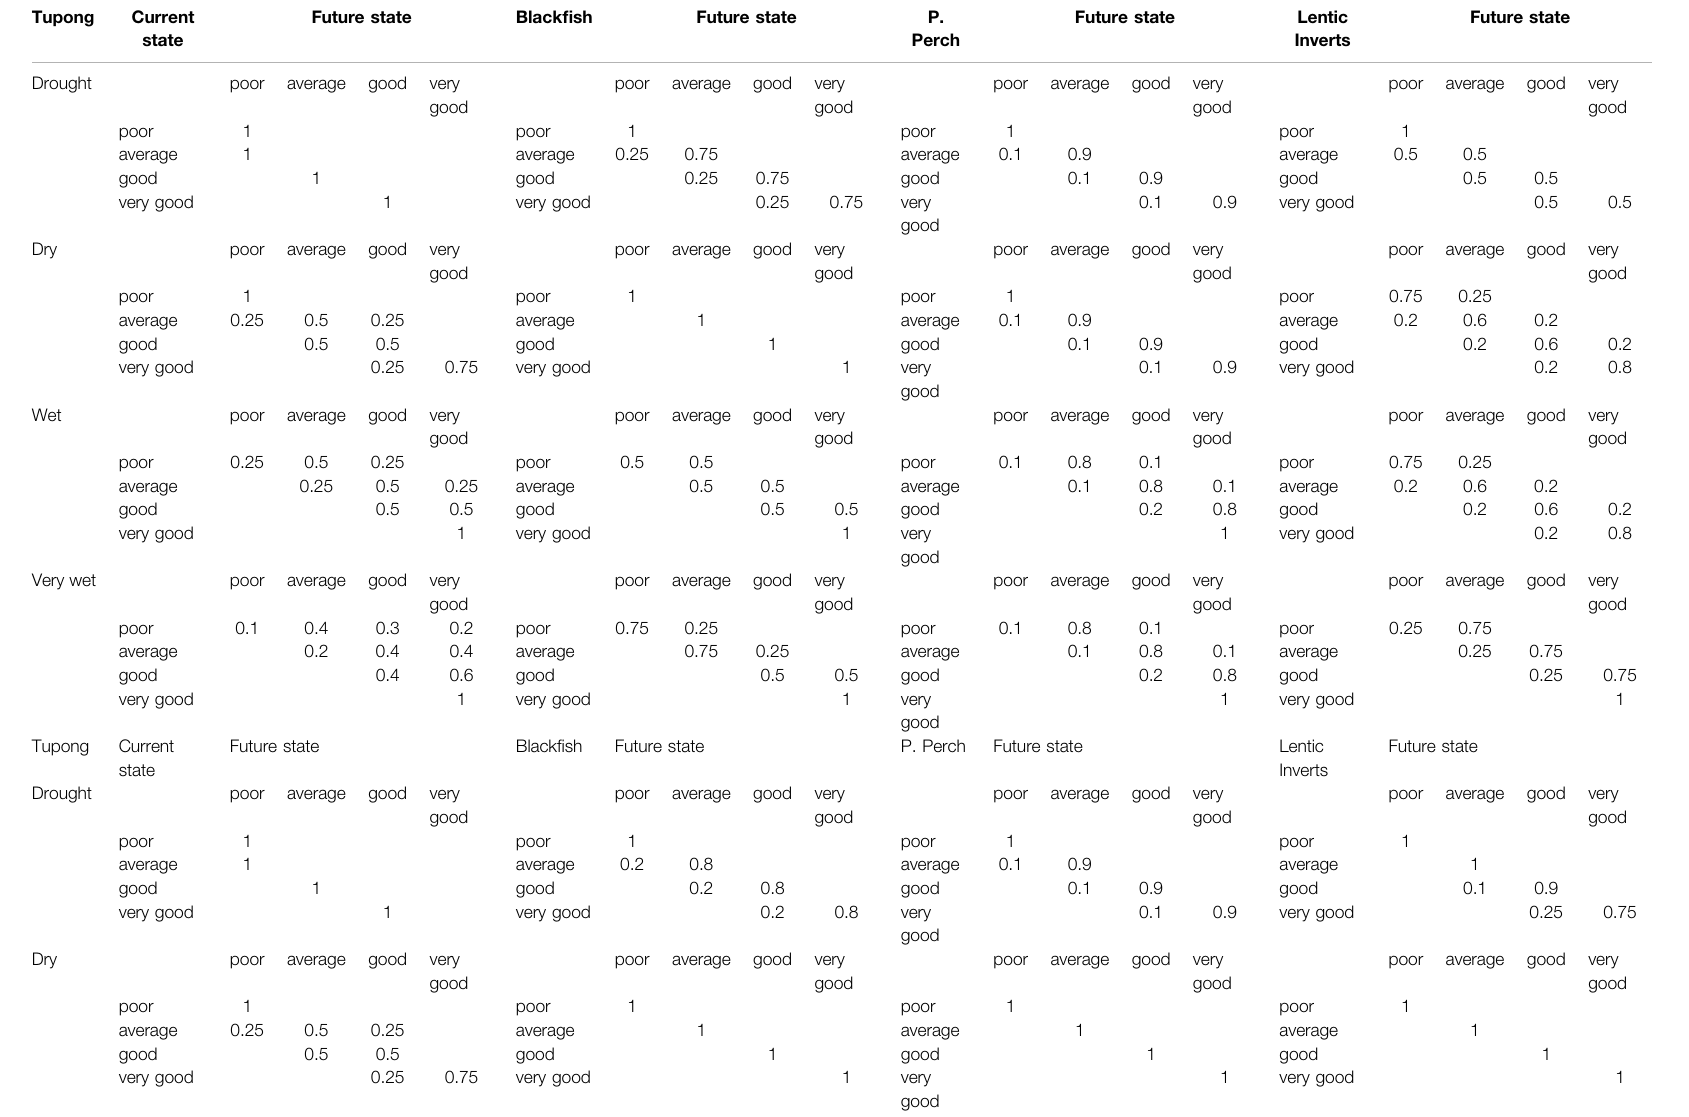
TABLE4| State-transition matrices foreightpriorityecologicalvalues(populations/communities)intheWerribeeRiver.Numbersineachtablerepresent theprobabilitythatthepopulation willtransitionfromthecurrentstate (left hand column) to the future state (top row) in a given time-step conditional on the hydrologic state (left-hand column). Tupong